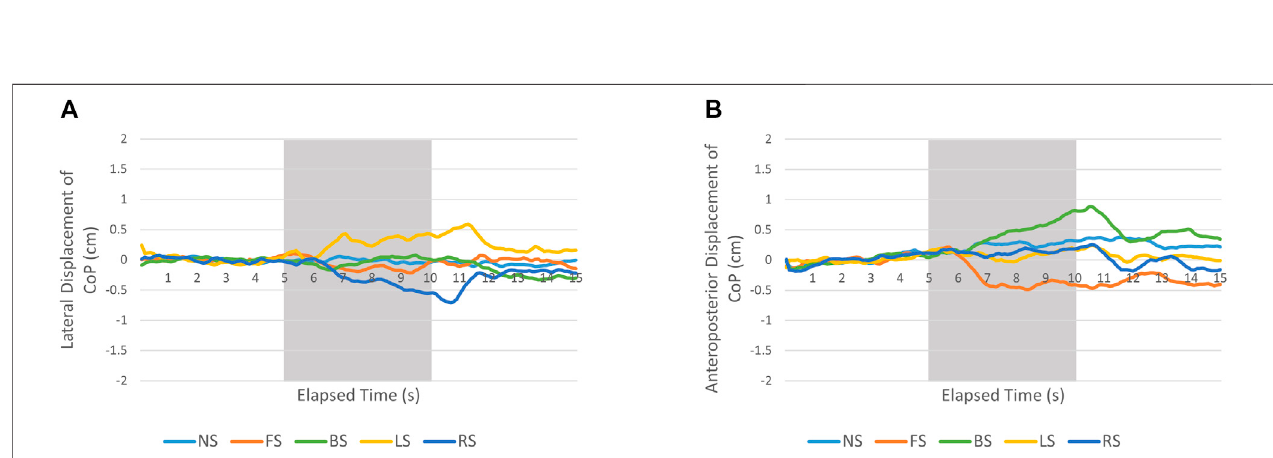
FIGURE 7 | Change in the CoP in the lateral direction (A) and anteroposterior direction (B) over time. The grey area indicates the interval in which electrical stimulation is applied. A positive lateral (anteroposterior) displacement indicates rightward (forward) motion. (NS: No stimulation, FS: front side, BS: back side, LS: left side, or RS: right